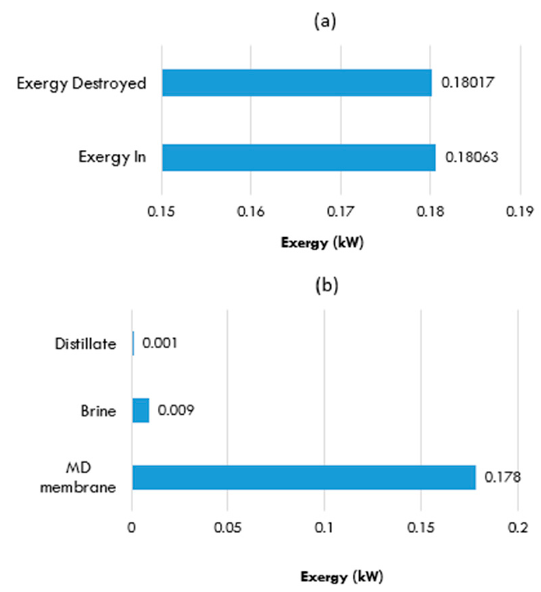
Figure 13. ( a ) Exergy balance of the solar powered MD unit without a heat exchanger; ( b ) exergy destruction in individual components.